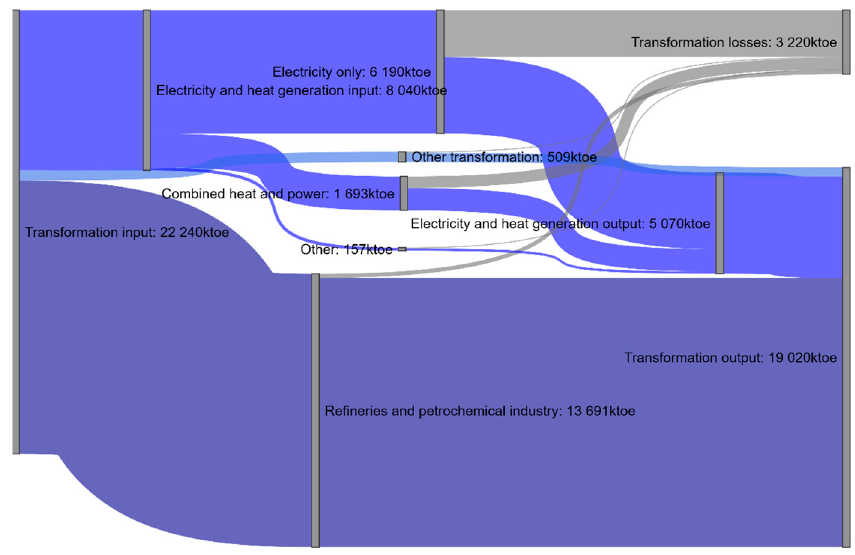
Figure 13. Portuguese energy balance flow for energy transformation–2019 data (adopted from Eurostat data).